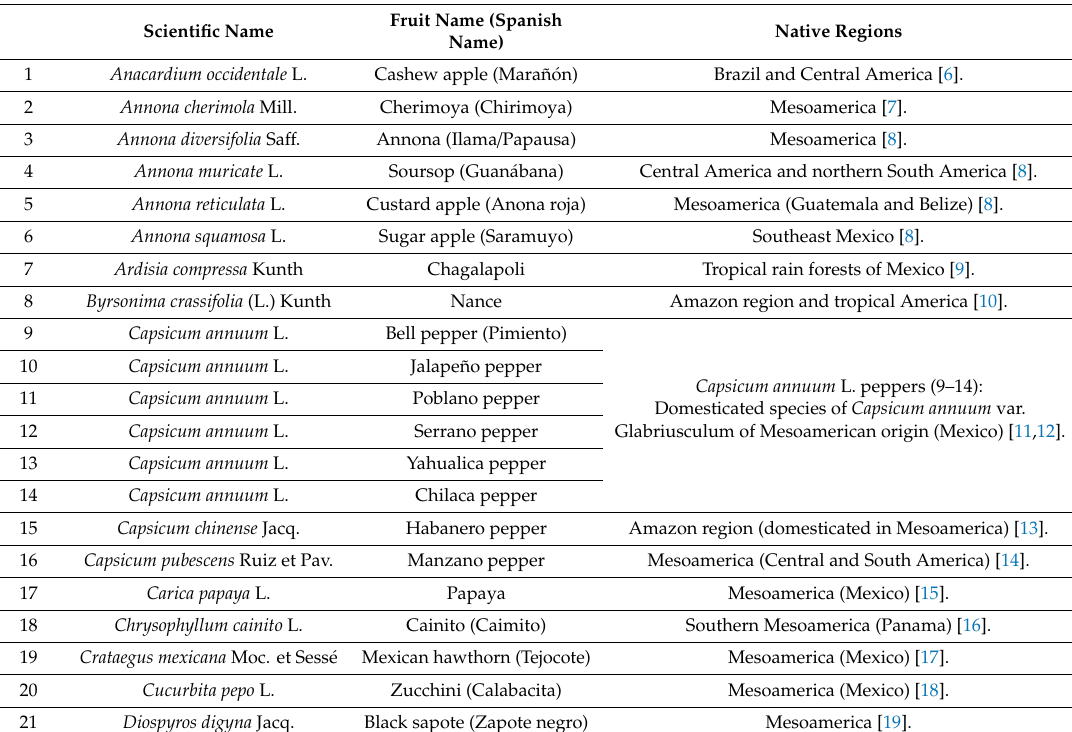
Table 1. Scientific name, description and geographical origin of the Mesoamerican fruits included in this